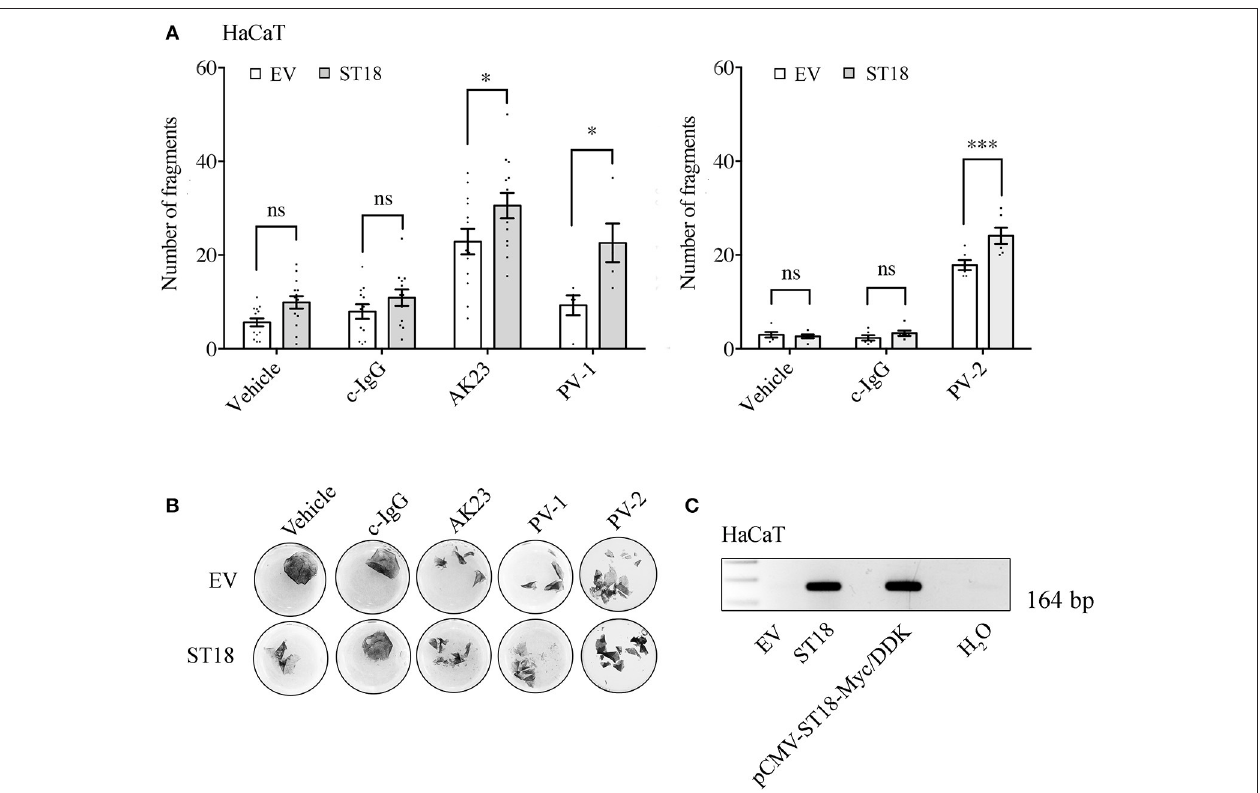
FIGURE 2 | ST18 enhances AK23- and PV-IgG-mediated loss of cohesion in cultured keratinocyte monolayers. (A) Dispase-based dissociation assay in HaCaT cells transiently transfected with a control empty (EV) or a ST18-expression vector and exposed to either c-IgG, AK23, or PV-IgG fractions ( n ≥ 0.05, two-way ANOVA, * p ≤ 0.05 and *** p ≤ 0.001 vs. respective monolayers transfected with EV). (B) Representative images of keratinocyte monolayers pre-stained with 10 µ M MTT for better visualization of the fragments. (C) PCR analysis validating sufficient transfection efficiency was performed for each single experiment. Positive (pCMV-ST18-Myc/DDK vector) and negative (H 2 O) controls were run in